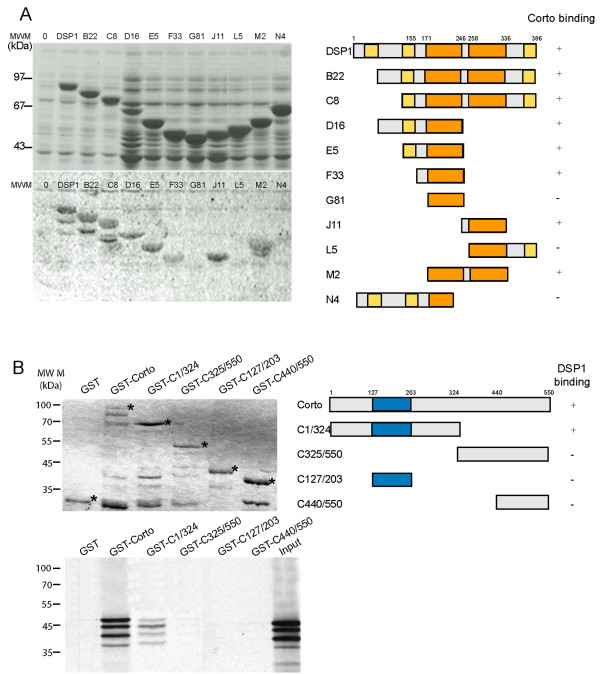
Corto and DSP1 interact in vitro. (A) Far-western assays. Left, top: Coomassie-stained SDS-PAGE of the MBP-DSP1 fusion proteins. Left, bottom: Phosphorimager scan of the membrane after transfer of the proteins and incubation with radiolabeled Corto. Right: Schematic representation of DSP1 and DSP1 truncated forms (orange: HMG-A and HMG-B boxes; yellow: polyglutamine series and acidic tail). Corto is retained on MBP-DSP1 and on B22, C8, D16, E5, F33, J11 and M2 MBP-DSP1 truncated forms but not on G81, L5 and N4 MBP-DSP1 truncated forms. (B) GST pull-down assays Left, top: Coomassie blue staining of GST and GST-Corto fusion proteins (labeled with asteriks). Left, bottom: Autoradiography. 35S-labeled DSP1 was retained on GST-Corto and GST-C1/324 proteins and not on GST-C325/550, GST-C127/203 or GST-C440/550. Input: 1/5 of the total radioactivity was loaded. Note that the full-length DSP1 protein as well as the truncated forms (degradation products or abortive translations) are retained on GST-Corto and GST-C1/324. Right : Schematic representation of Corto (blue : chromodomain).